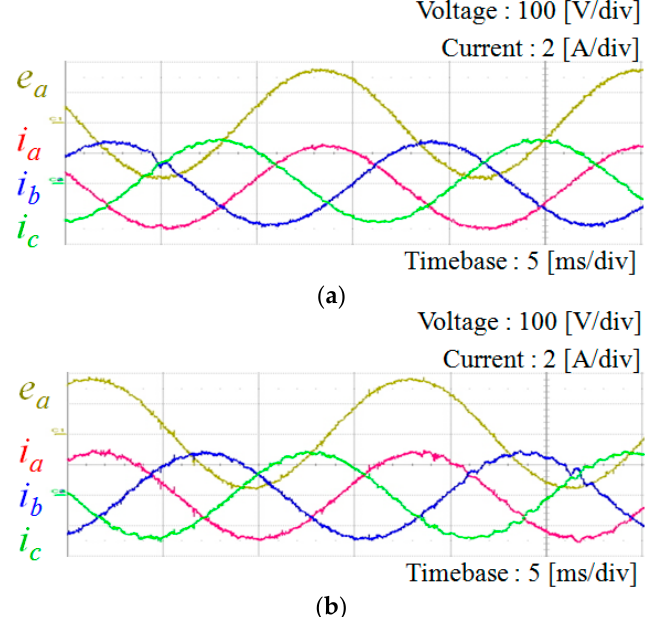
Figure 17. Comparative experimental results for inverter output currents under the ideal grid condition. ( a ) With the conventional PR control with voltage measurements; and ( b ) with the proposed voltage-sensorless control.